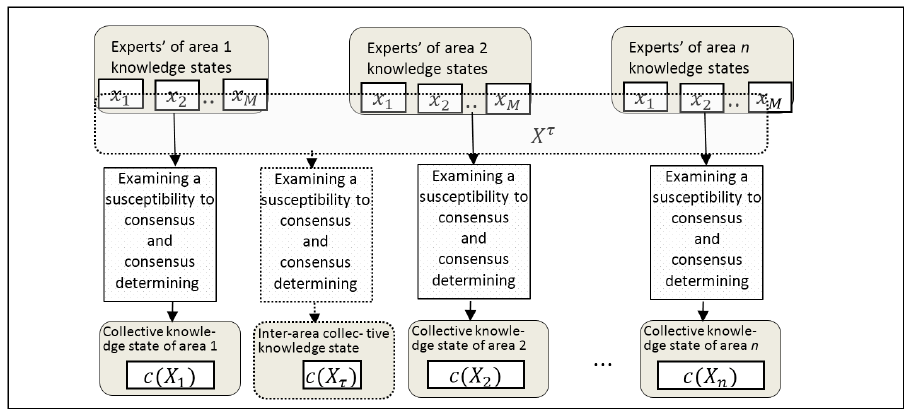
Fig. 2. Integration of a collective knowledge of business